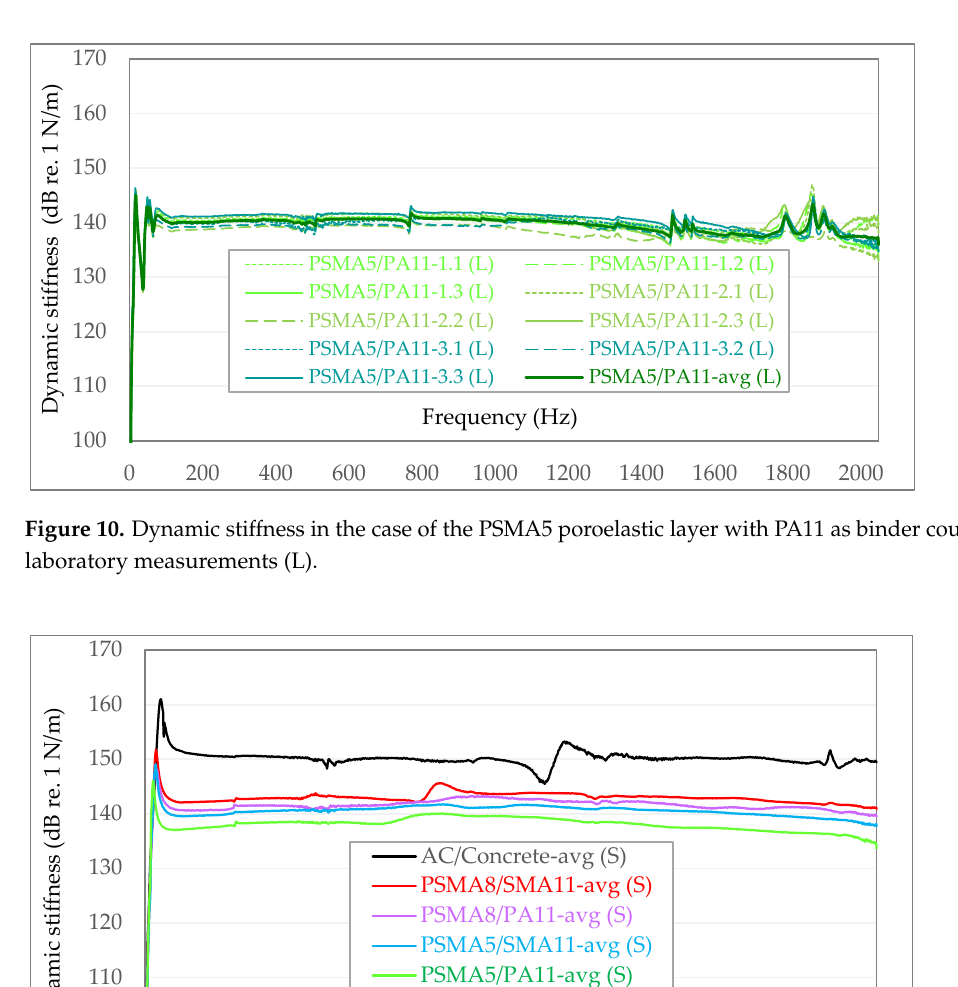
Figure 12. Summary of averaged values of dynamic stiffness from individual measurement series for measurements on samples in the laboratory (L). To visualize the differences in the dynamic stiffness obtained as a result of field tests carried out directly on asphalt surfaces and tests carried out in laboratory conditions, all averaged values were summarised in one graph (Figure 13):